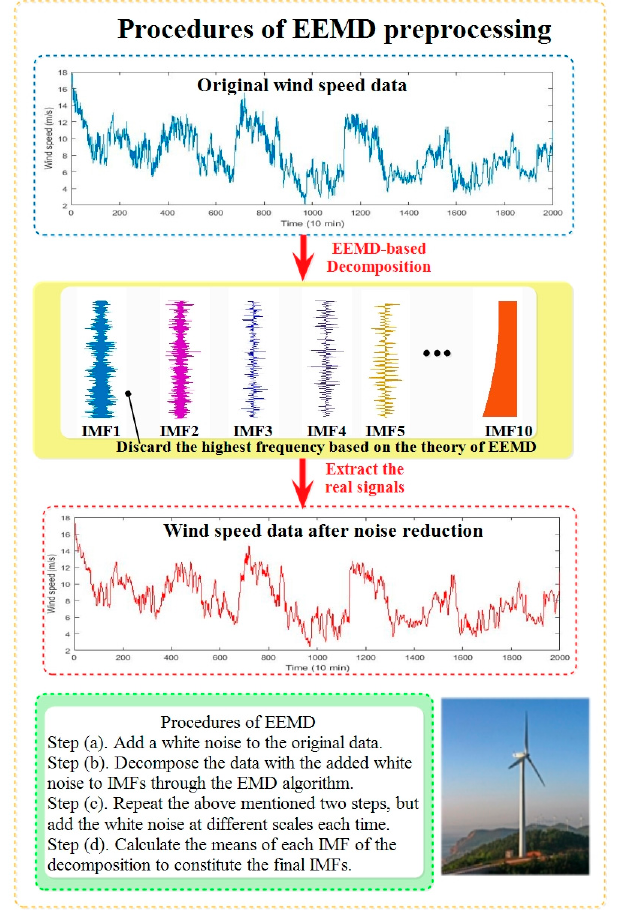
Figure 4. Wind speed data noise reduction using EEMD preprocessing process.